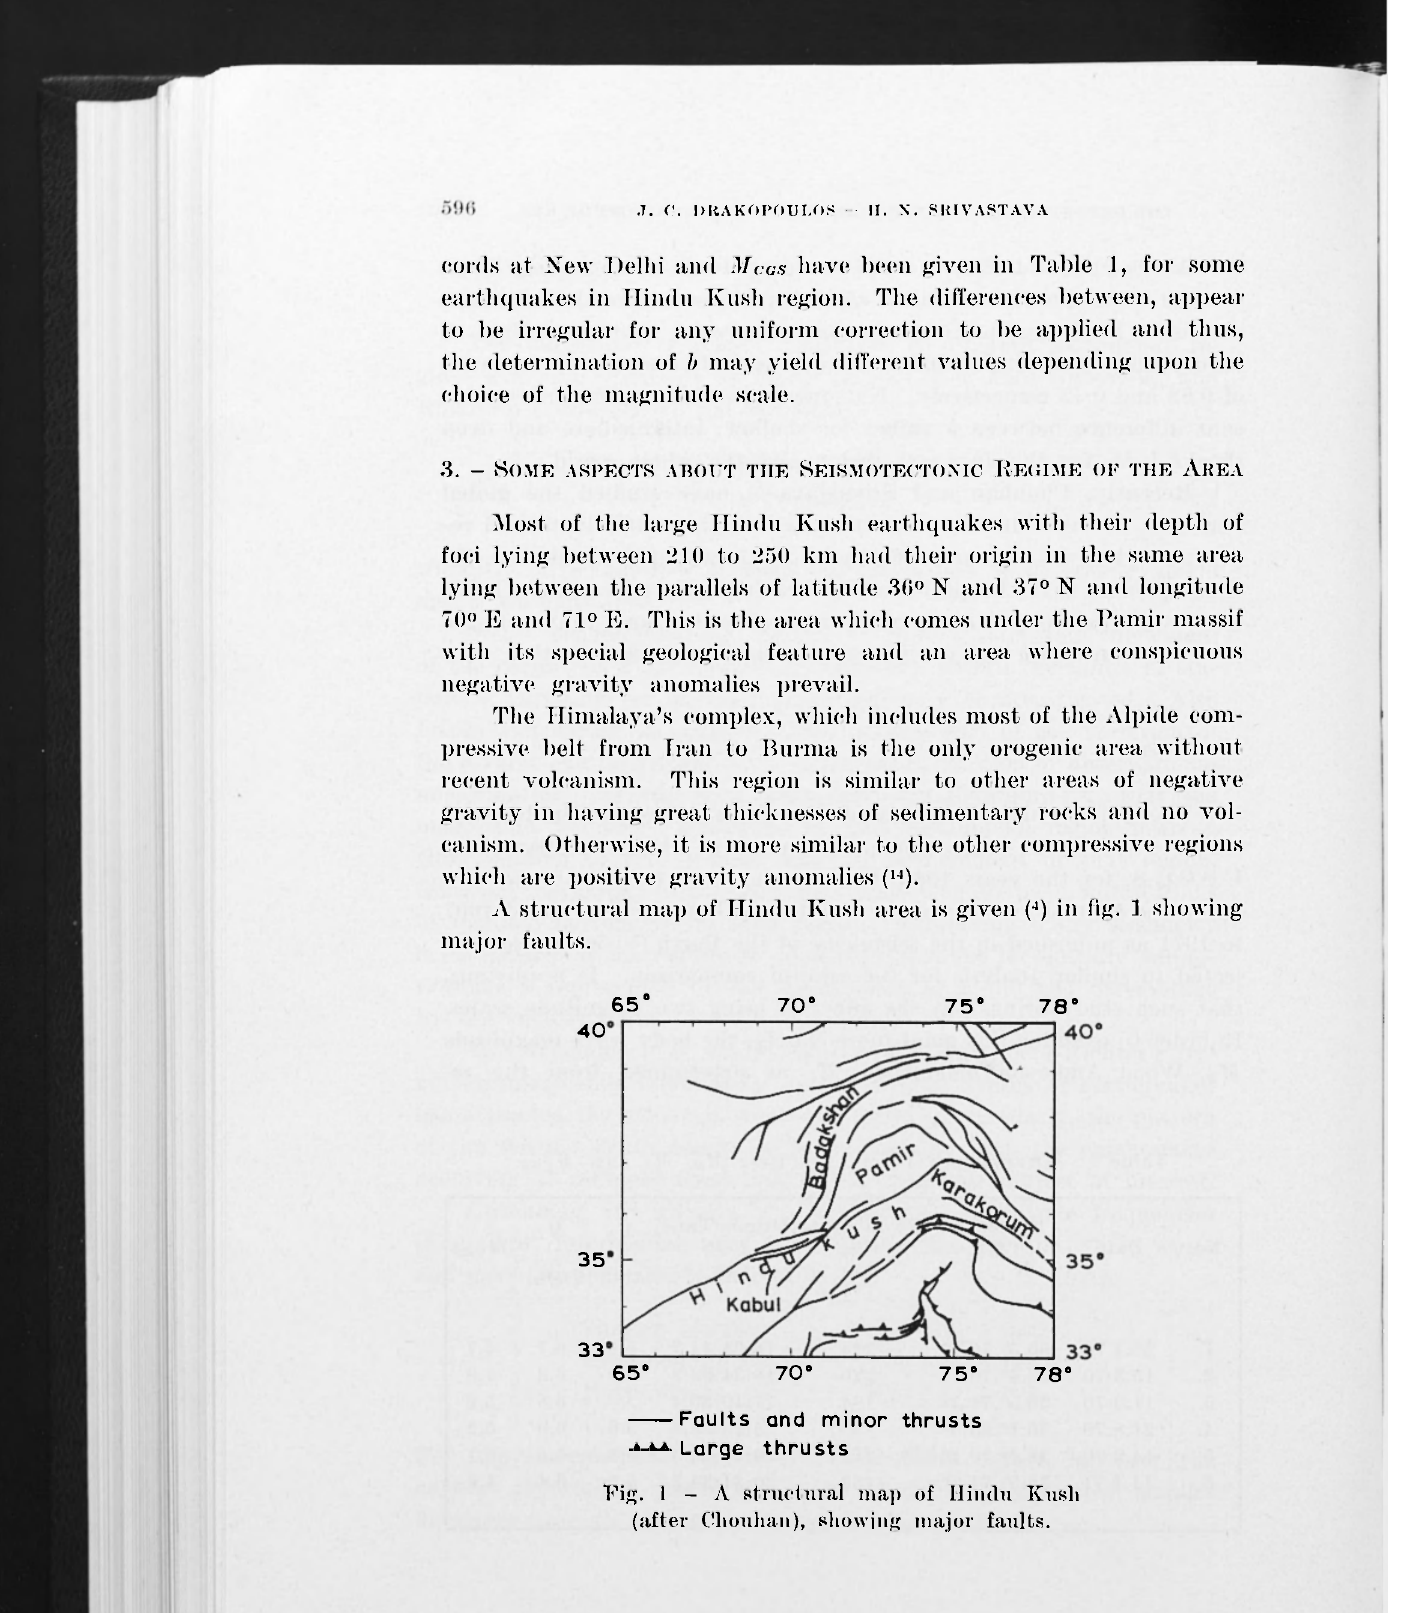
Fig. 1 - A structural map of Hindu Kush (after Choulian), showing major